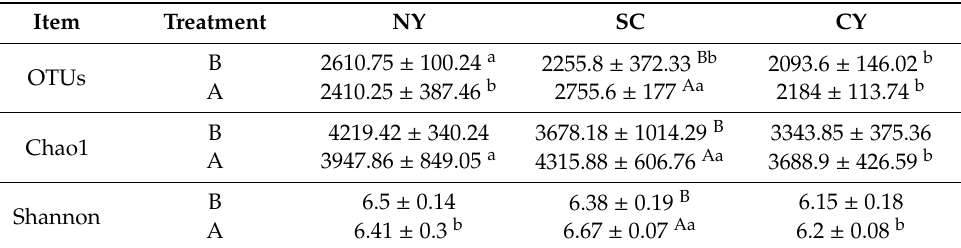
Table 4. Alpha diversity indices.